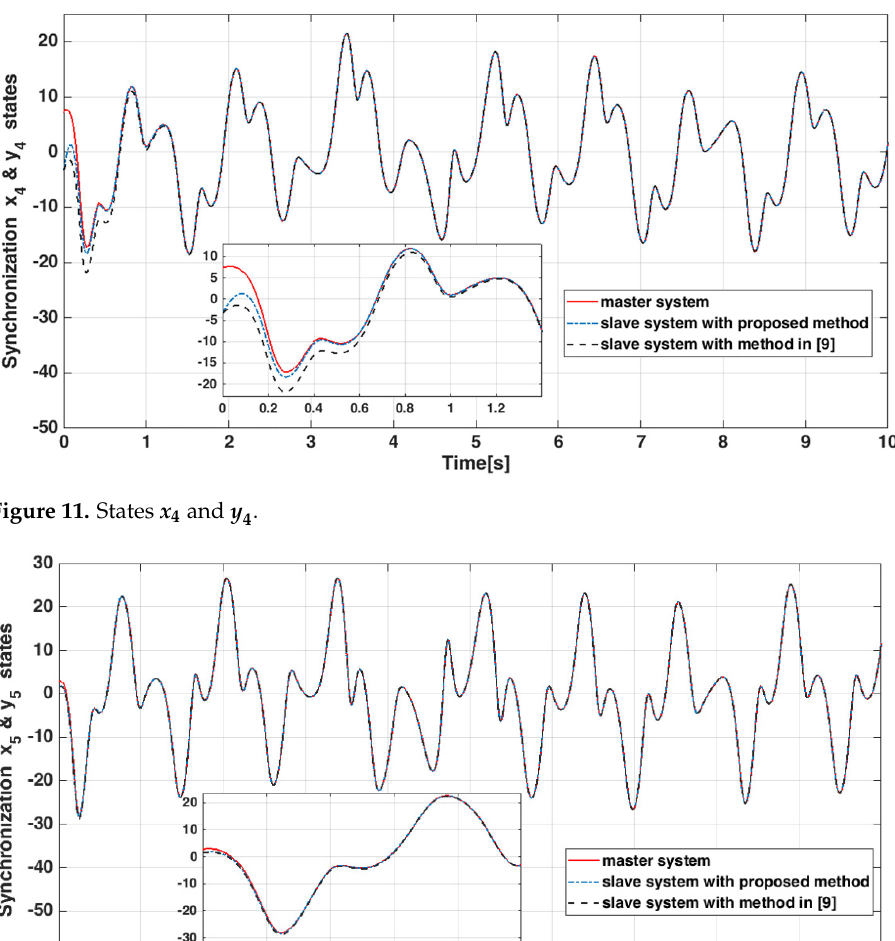
Figure 10. Time responses of states 𝒙 𝟑 and 𝒚 𝟑